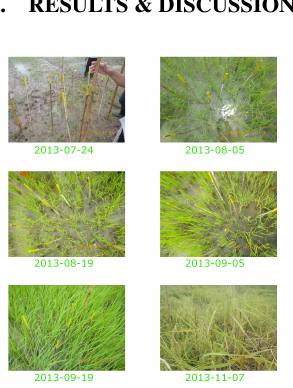
Figure 5: Geo-tag photograph time series of rice paddy cultiva- tion